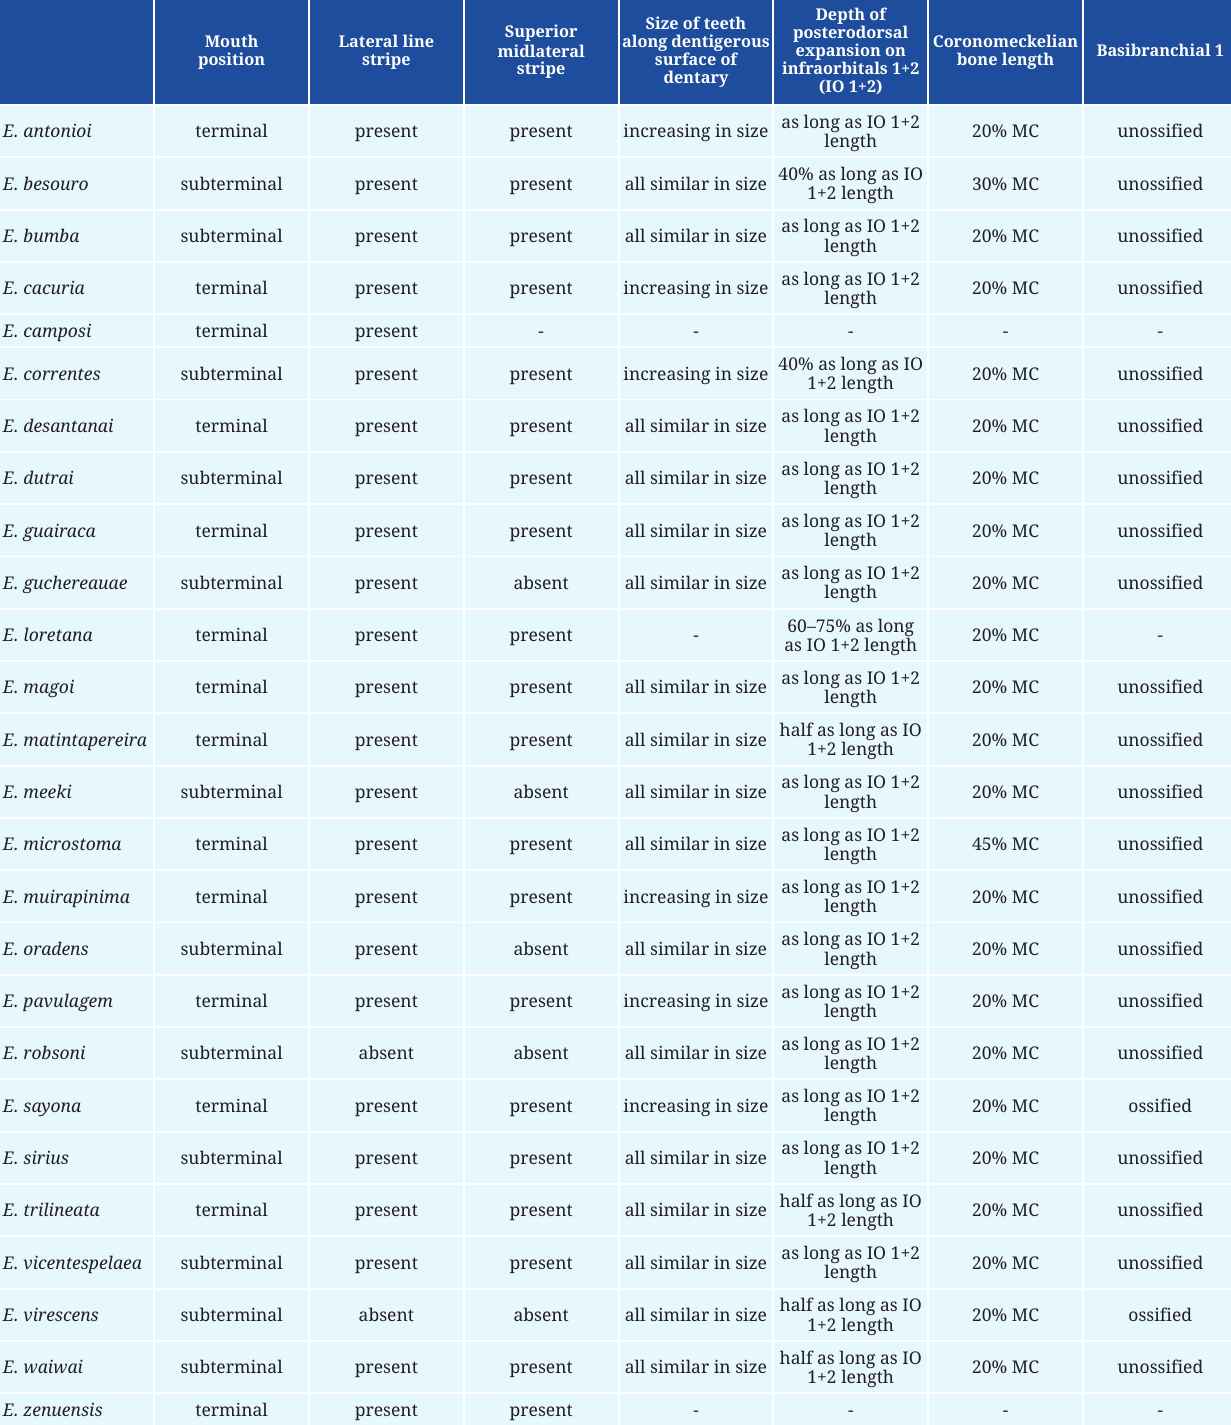
TABLE 2 | Summary of external and osteological diagnostic characters for the 26 recognized species of the Eigenmannia trilineata species- group. Table redrawn and modified from Waltz, Albert (2018) based on compiled data from Peixoto et al . (2015), Peixoto, Wosiacki (2016), Campos-da-Paz, Queiroz (2017), Dutra et al . (2017, 2018, 2021), Peixoto, Waltz (2017), Peixoto, Ohara (2019), Herrera-Collazos et al. (2020), and Peixoto et al. (2020). Dashes represent data not available in the